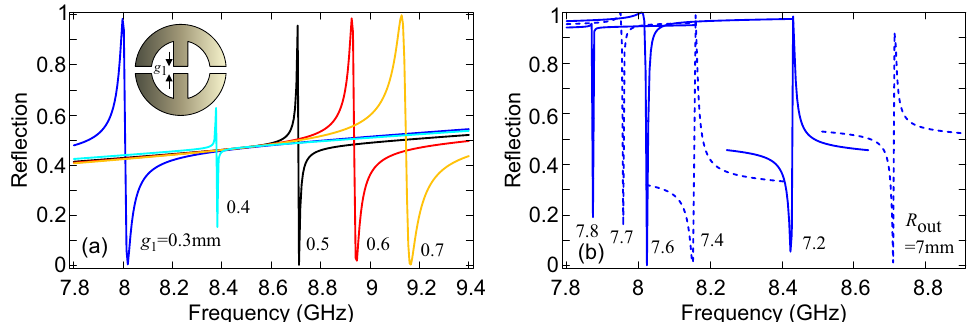
Figure 3. ( a ) Tuning the central gap ( g 1 ), while keeping other gaps ( g 2 ) constant at 0.5 mm. This controls the residual electric dipole moment and consequently the radiative strength of the resonance. ( b ) Varying the outer radius for R inn = R out − w with w = 2 mm. As the radius increases, the non-resonant (background) electric dipole moment changes and with it the Fano lineshape. For R out values of 7.6, 7.7, and 7.8 mm, the meta-atoms are touching; this modifies the residual electric dipole moment, as the outer gaps of each meta-atom begin to merge with those of the neighboring one. Table 1. Quality factors for the cases depicted in Figure 3a. g 2 is held constant at 0.5 mm. They have been calculated using the complex eigenfrequency through Q = ω (cid:48) / ( 2 ω (cid:48)(cid:48) ) . Central Gap g ( mm 1